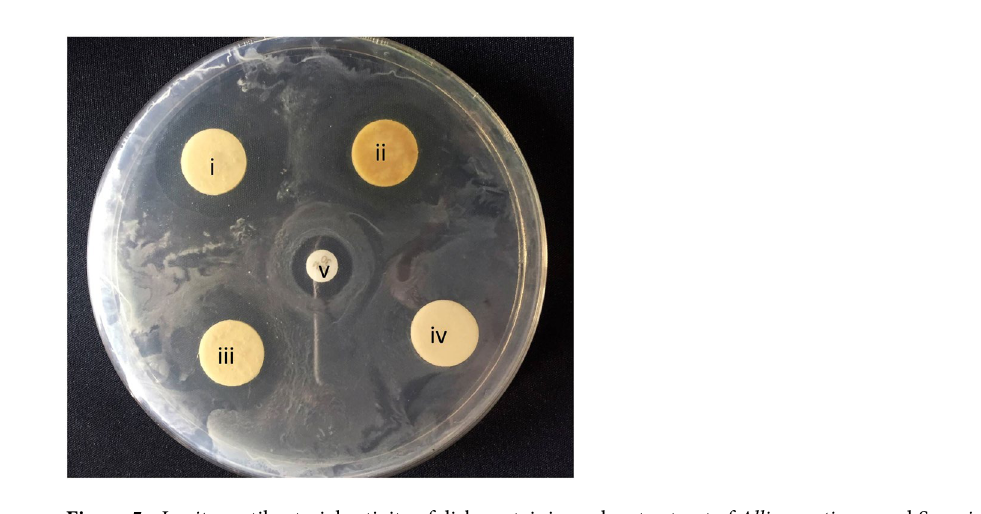
Figure 5. In vitro antibacterial activity of disk containing solvent extract of Allium sativum and Syzygium aromaticum . Note: (i) methanol extract of S. aromaticum , (ii) acetone extract of S . aromaticum , (iii) Acetone extract of A . sativum , (iv) Blank control, (v) Azithromycin antibiotic